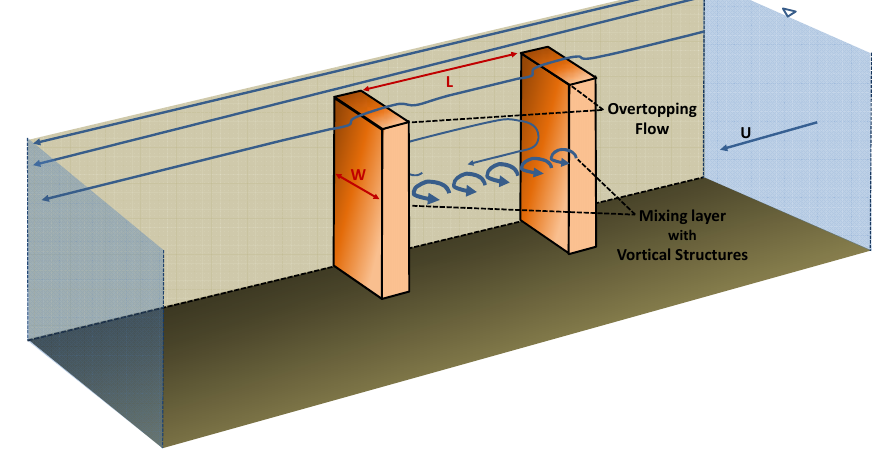
Fig. 4. Schematic of the flow field for a submerged lateral